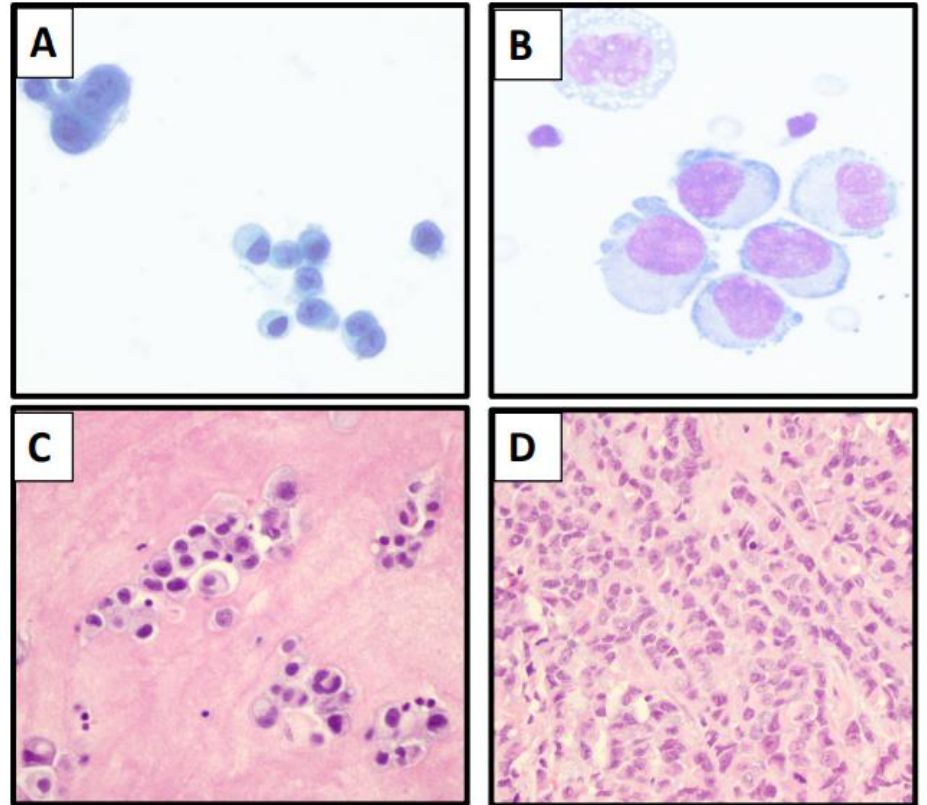
Figure 5. ( A – D ) Metastatic pleomorphic lobular carcinoma in pleural fluid. ( A , B ) Clusters of tumor cells with large cell size, pleomorphism and prominent nucleoli and cytoplasmic blebs. ( A ) ThinPrep (Papanicolaou stain) ( B ) DQ stain. ( C ) Cell block demonstrates small clusters and single pleomorphic cells. Cells have moderately abundant cytoplasm. ( D ) Concurrent breast biopsy with sheets of pleomorphic lobular cells cytomorphologically similar to the cell block specimen. (Images contributed by John P. Crapanzano, MD, Columbia University Medical Center).